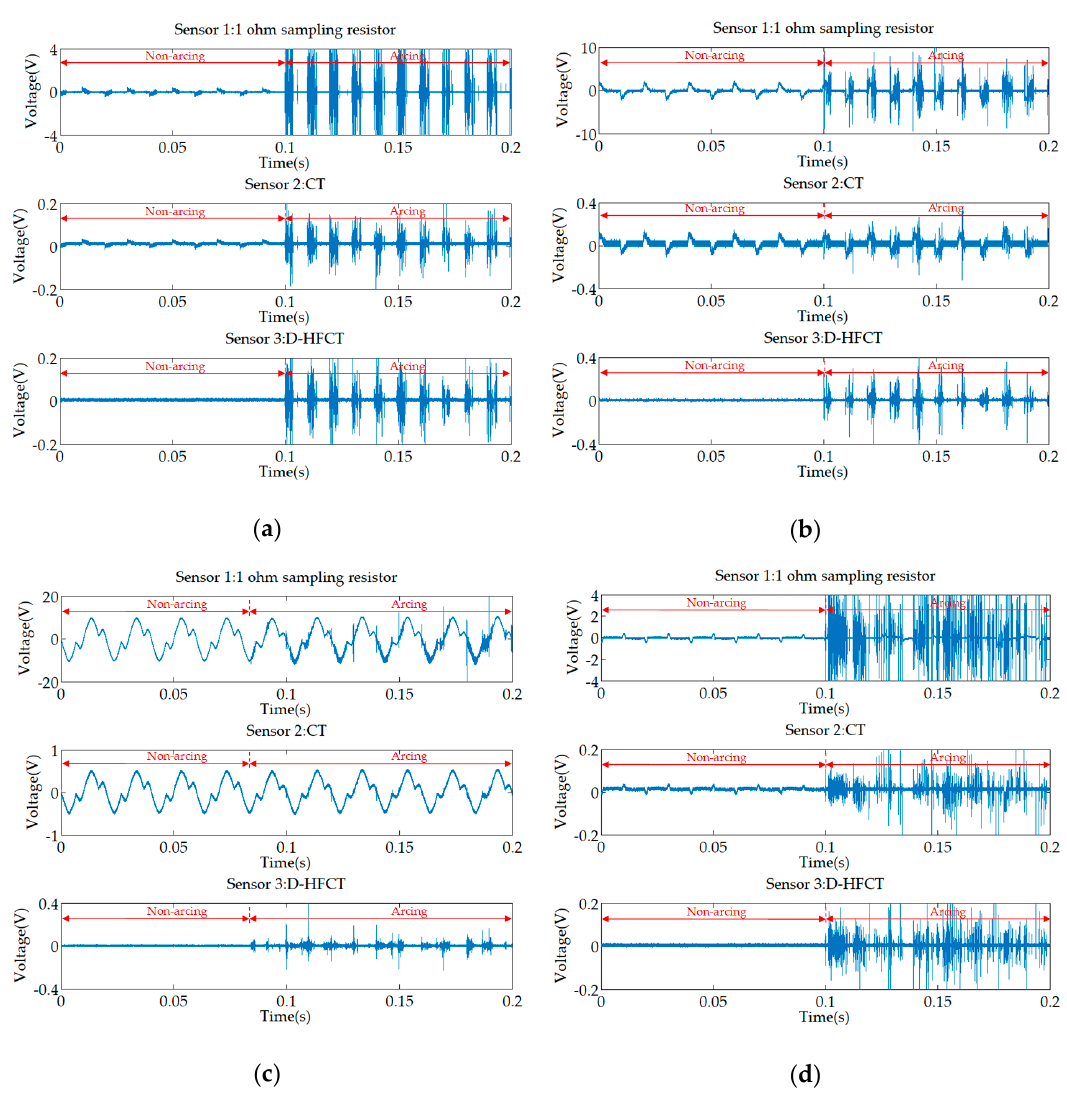
Figure 23. Experimental waveforms of non-linear loads. ( a ) Fluorescent lamp; ( b ) energy-saving lamp; ( c ) microwave oven; ( d ) computer screen.